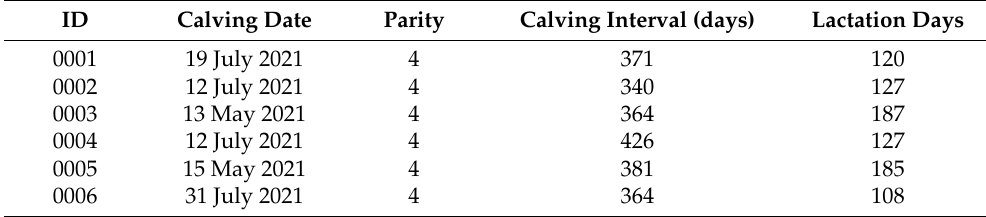
Table 1. Sampling cattle basic